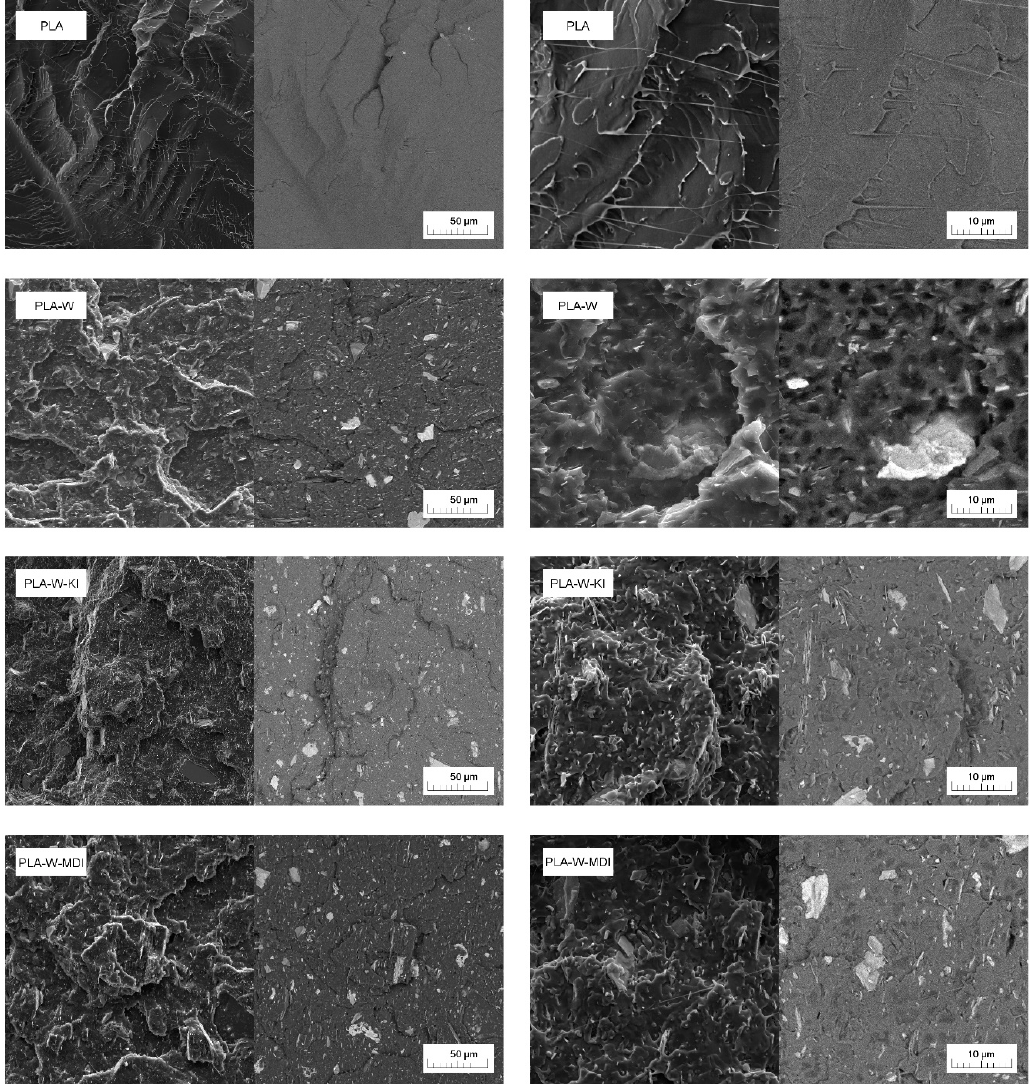
Figure 9. SEM images of PLA and PLA composites taken in SE and BSE mode with using 1000 × and 5000 × magnification.